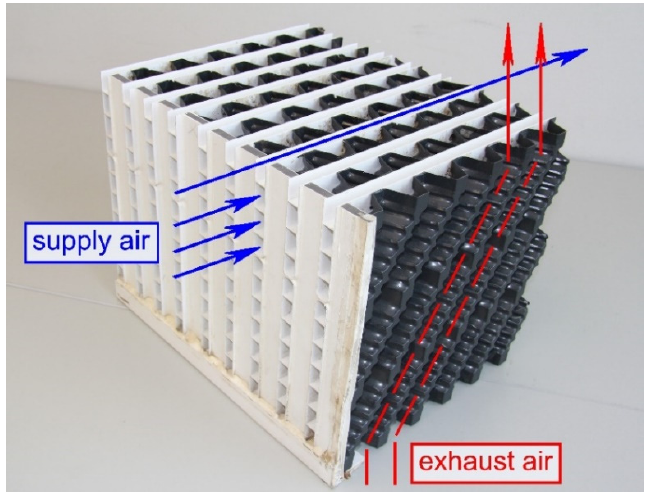
Figure 2. Cutaway model of the recuperative heat exchanger. The supply air was guided through the white, closed hollow chamber profiles ( blue arrows ). The exhaust air was guided vertically from bottom to top through the waveform structures sheets ( red arrows ). Supply air and exhaust air were separated from each other and could not mix.